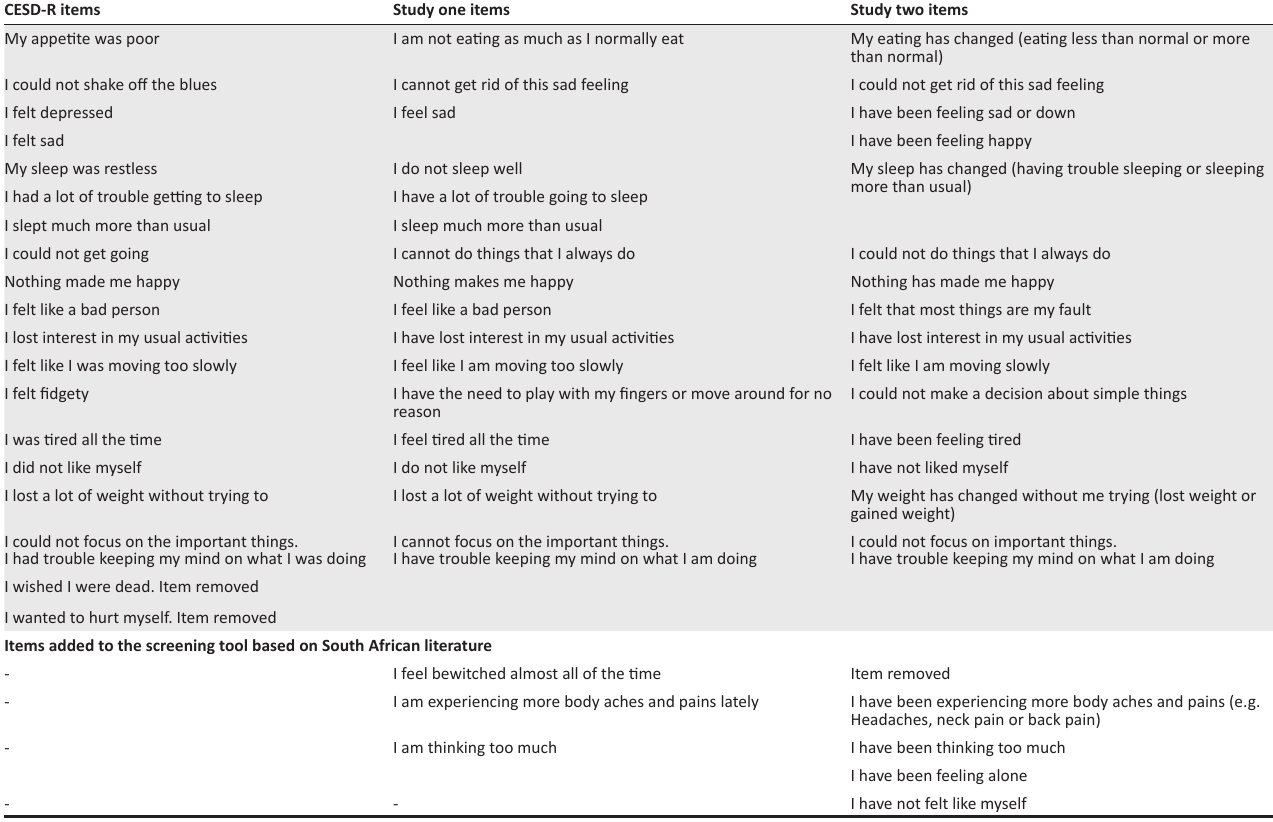
TABLE 1: Item adaptation for study one and study two. CESD-R